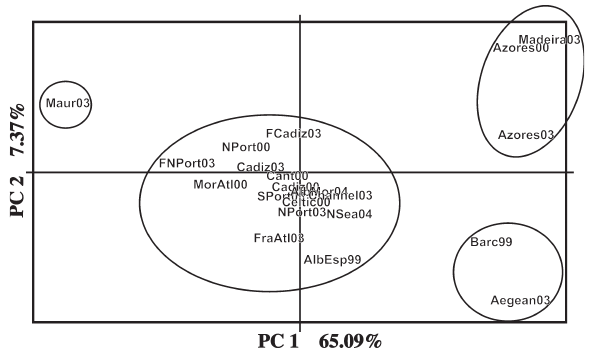
Fig . 2 – Principle component analysis of all 21 samples of sardine used in this study for 5 polymorphic microsatellite loci. Groupings refer to the inferred stocks of sardine. Sample abbreviations are as in Table 1.